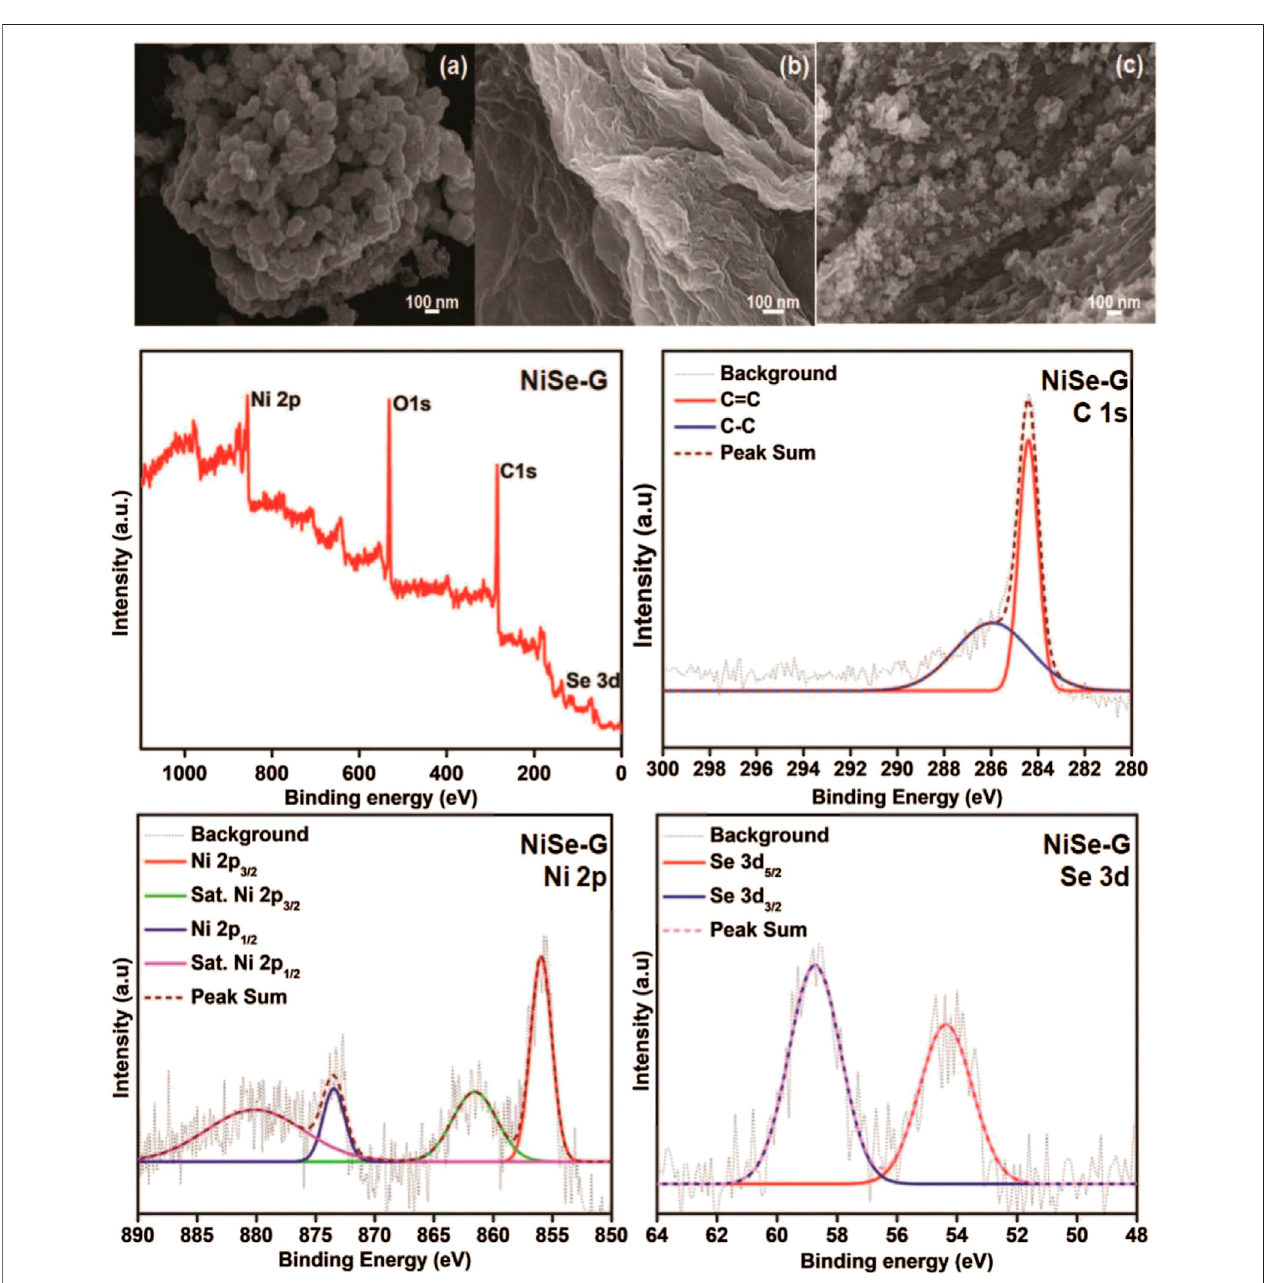
FIGURE 10 | NiSe nanoparticle material with excellent